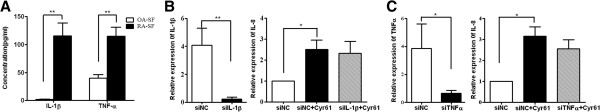
IL-1β and TNF-α are not involved in Cyr61-induced IL-8 expression in FLS. (A) The protein levels of IL-1β and TNF-α in SF from RA and OA patients were detected by ELISA. (B) IL-8 mRNA expression in IL-1β-knockdown FLS was detected by real-time PCR. Left panel, the sequence for siIL-1β (small interfering RNA against IL-1β) was evaluated. The IL-1β mRNA expression in FLS transfected with siIL-1β (black bar) or siNC (control, open bar) was measured by real-time PCR. Right panel, FLS were transfected with siIL-1β or siNC for 4 hours, cultured for 20 hours and incubated for an additional 2 hours in the presence or absence of Cyr61 (5 μg/ml). IL-8 mRNA expression in FLS was detected by real-time PCR. (C) IL-8 mRNA expression in TNF-α-knockdown FLS was detected by real-time PCR. Data represent the mean ± SEM of at least three independent experiments. * P <0.05, ** P <0.01. FLS, fibroblast-like synoviocytes; OA, osteoarthritis; RA, rheumatoid arthritis; SEM, standard error of the mean; siNC, control siRNA.